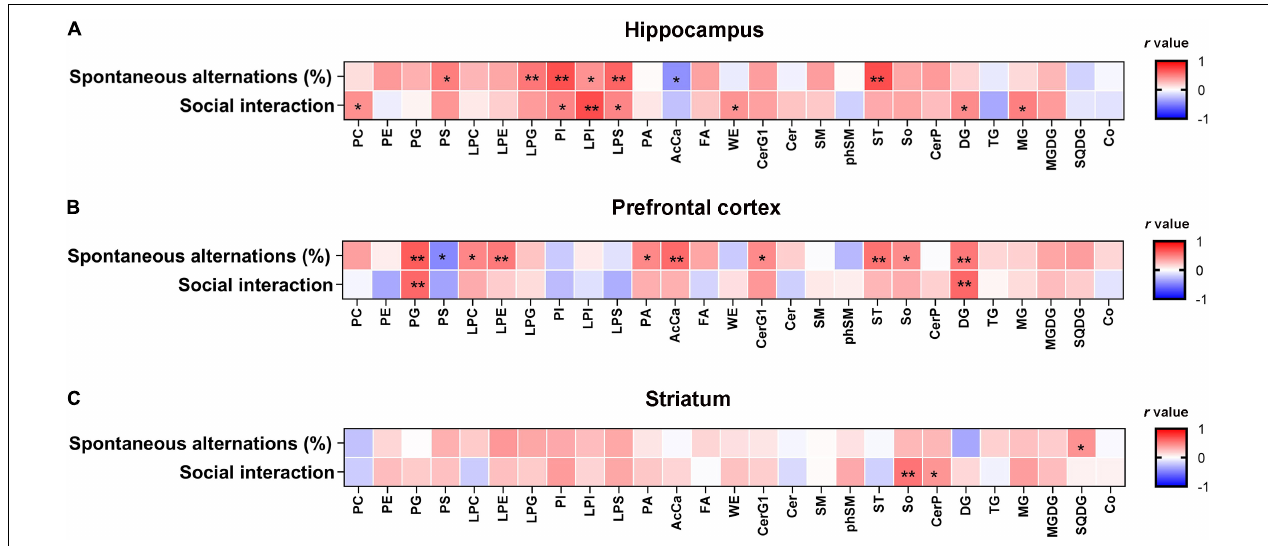
FIGURE 3 | Correlation analysis between cognitive behavior and the lipid levels in the hippocampus, PFC, and striatum. (A) The hippocampal PI, PS, LPI, and LPS levels were negatively correlated with the severity of cognitive behavioral impairment. (B) The PFC AcCa, DG, and PG levels were negatively correlated with the severity of the cognitive behavioral impairment. (C) The striatum SQDG level was positively correlated with the percentage of spontaneous alternations and So levels was positively correlated with the percentage of interaction time. The correlation between the lipid levels and cognitive behavior was analyzed using the Pearson’s correlation coefficient. *P < 0.05, **P <